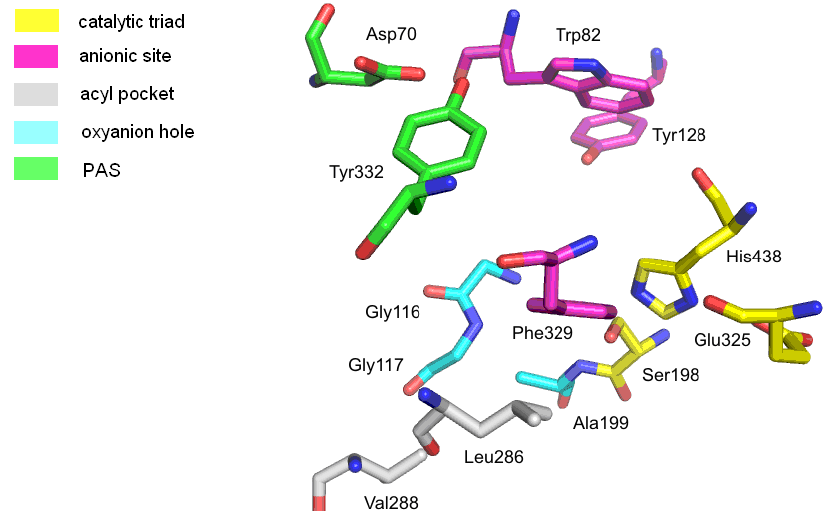
Figure 3. Active site of butyrylcholinesterase (human butyrylcholinesterase (hBuChE), PDB: